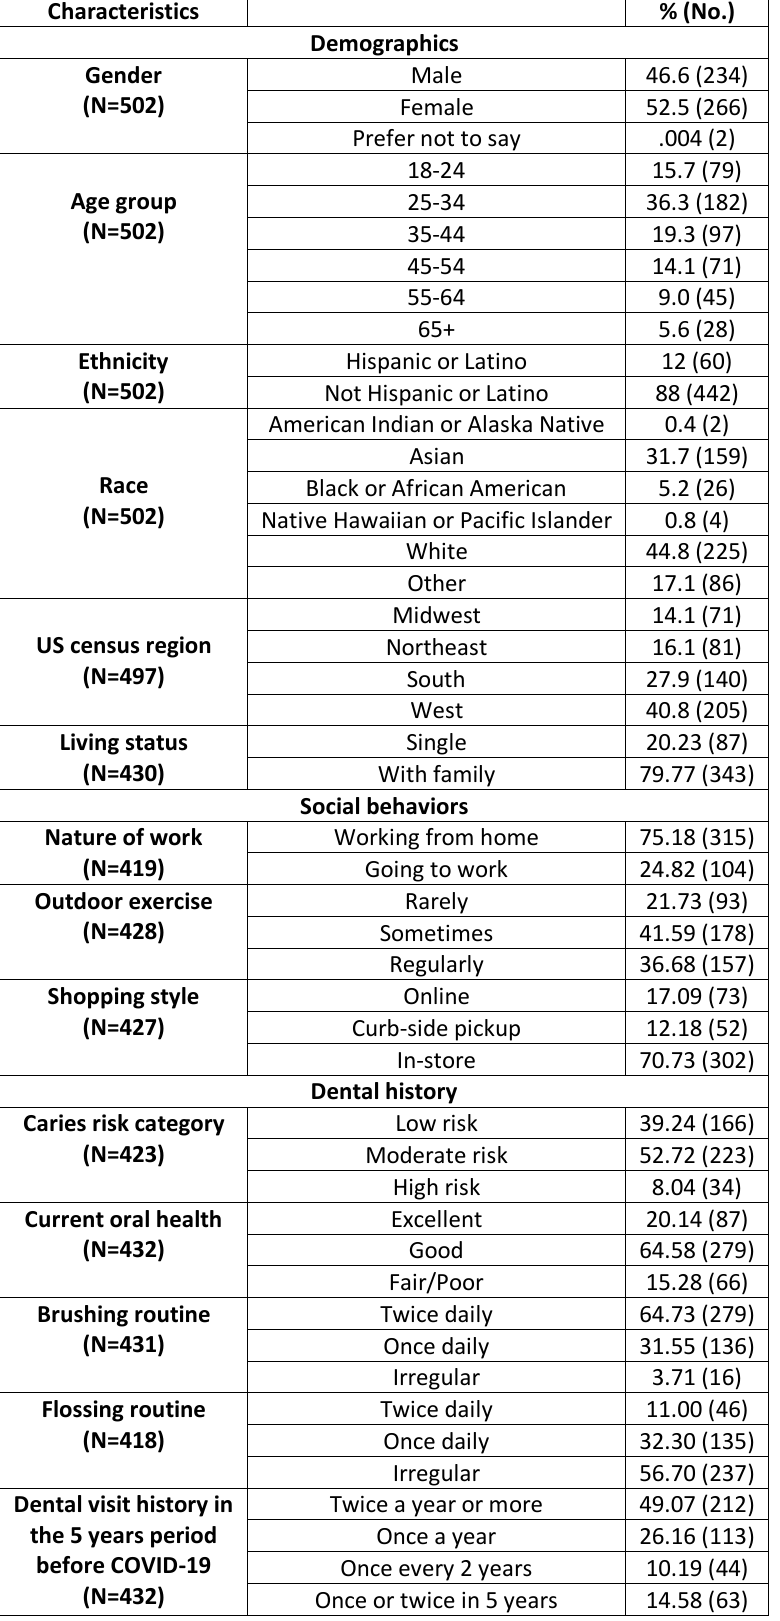
Table 1 - Demographics, social behaviors, and dental history of